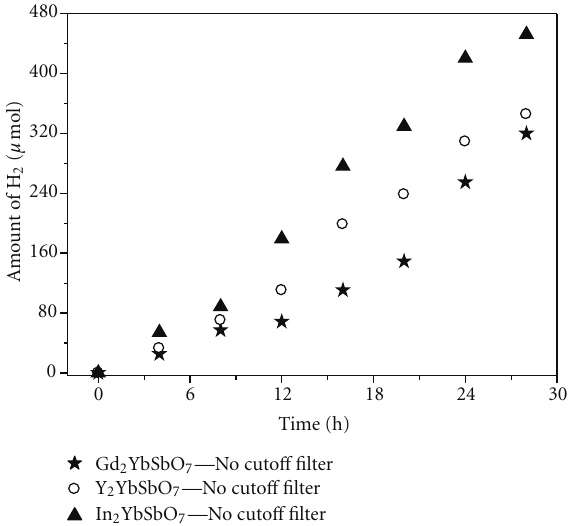
Figure 7: E ff ect of Pt, NiO, and RuO 2 co-catalysts on the photoactivity of In 2 YbSbO 7 under visible light irradiation ( λ > 420nm, 0.5 g powder sample, 50mL methanol solution, 200 mL pure water). Light source: 300W Xe